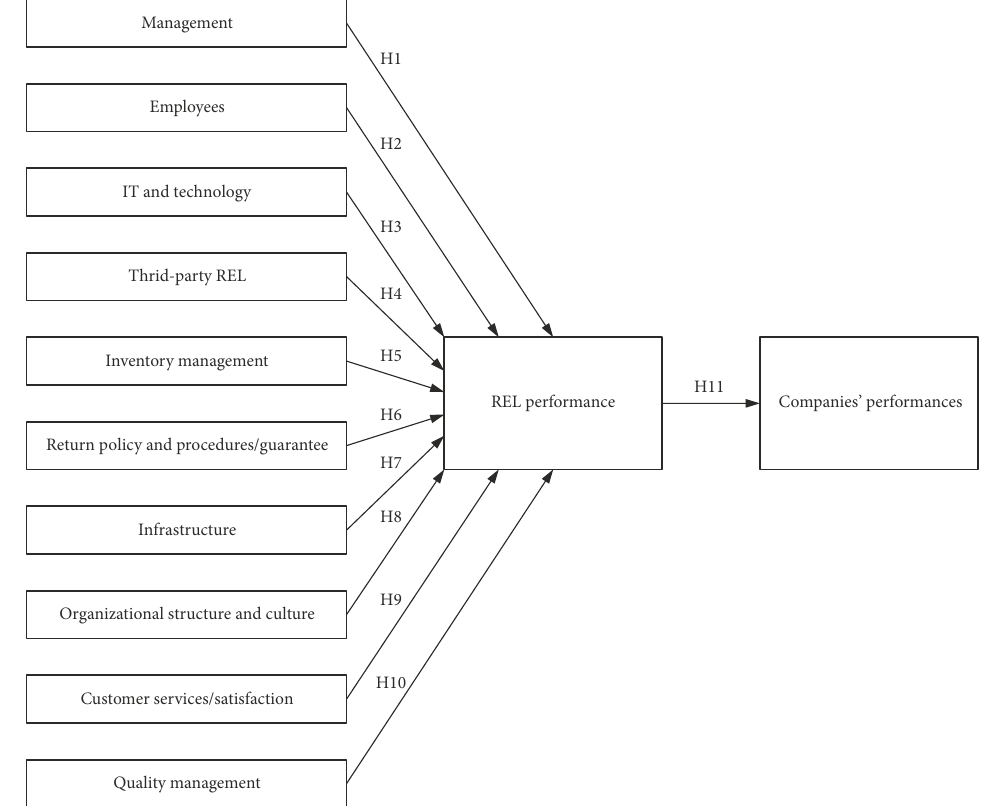
Figure 2. Theoretical framework (source: compiled by authors